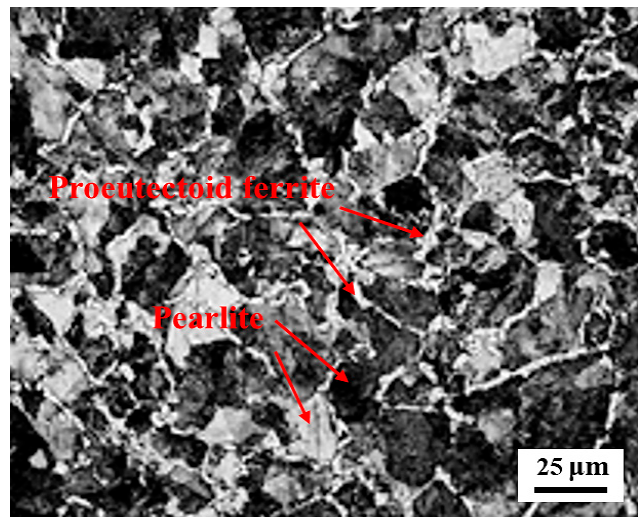
Figure 1. The original microstructure of D2 wheel steel.